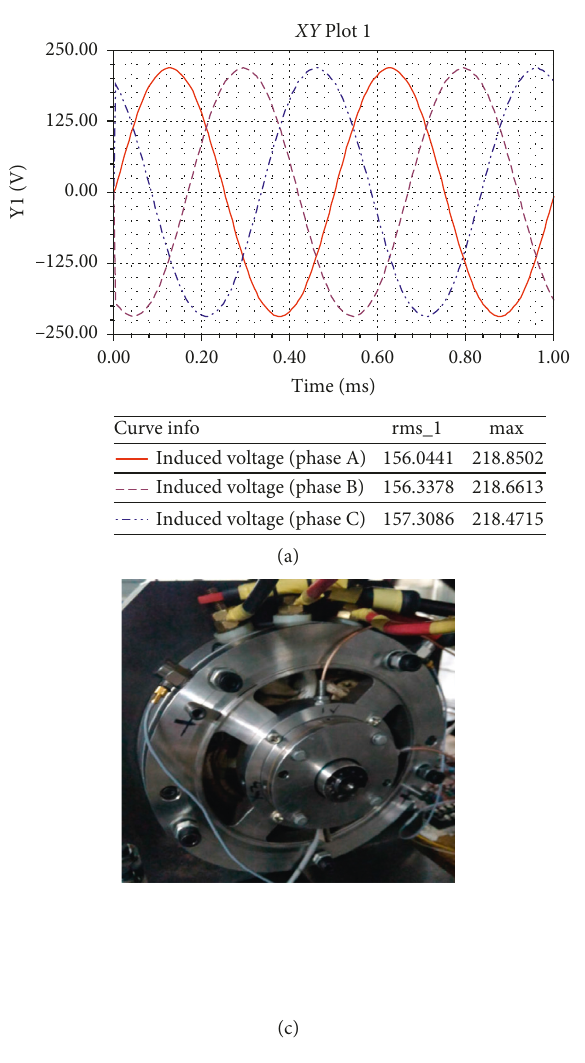
Figure 6: Results of the no-load back-emf. (a) No-load back-emf of FEM at 120,000 rpm. (b) Comparison of no-load back-emf at 120,000rpm. (c) Prototype of the ultra-high-speed PMSM. (d) Experimental curves of the phase voltage and frequency.